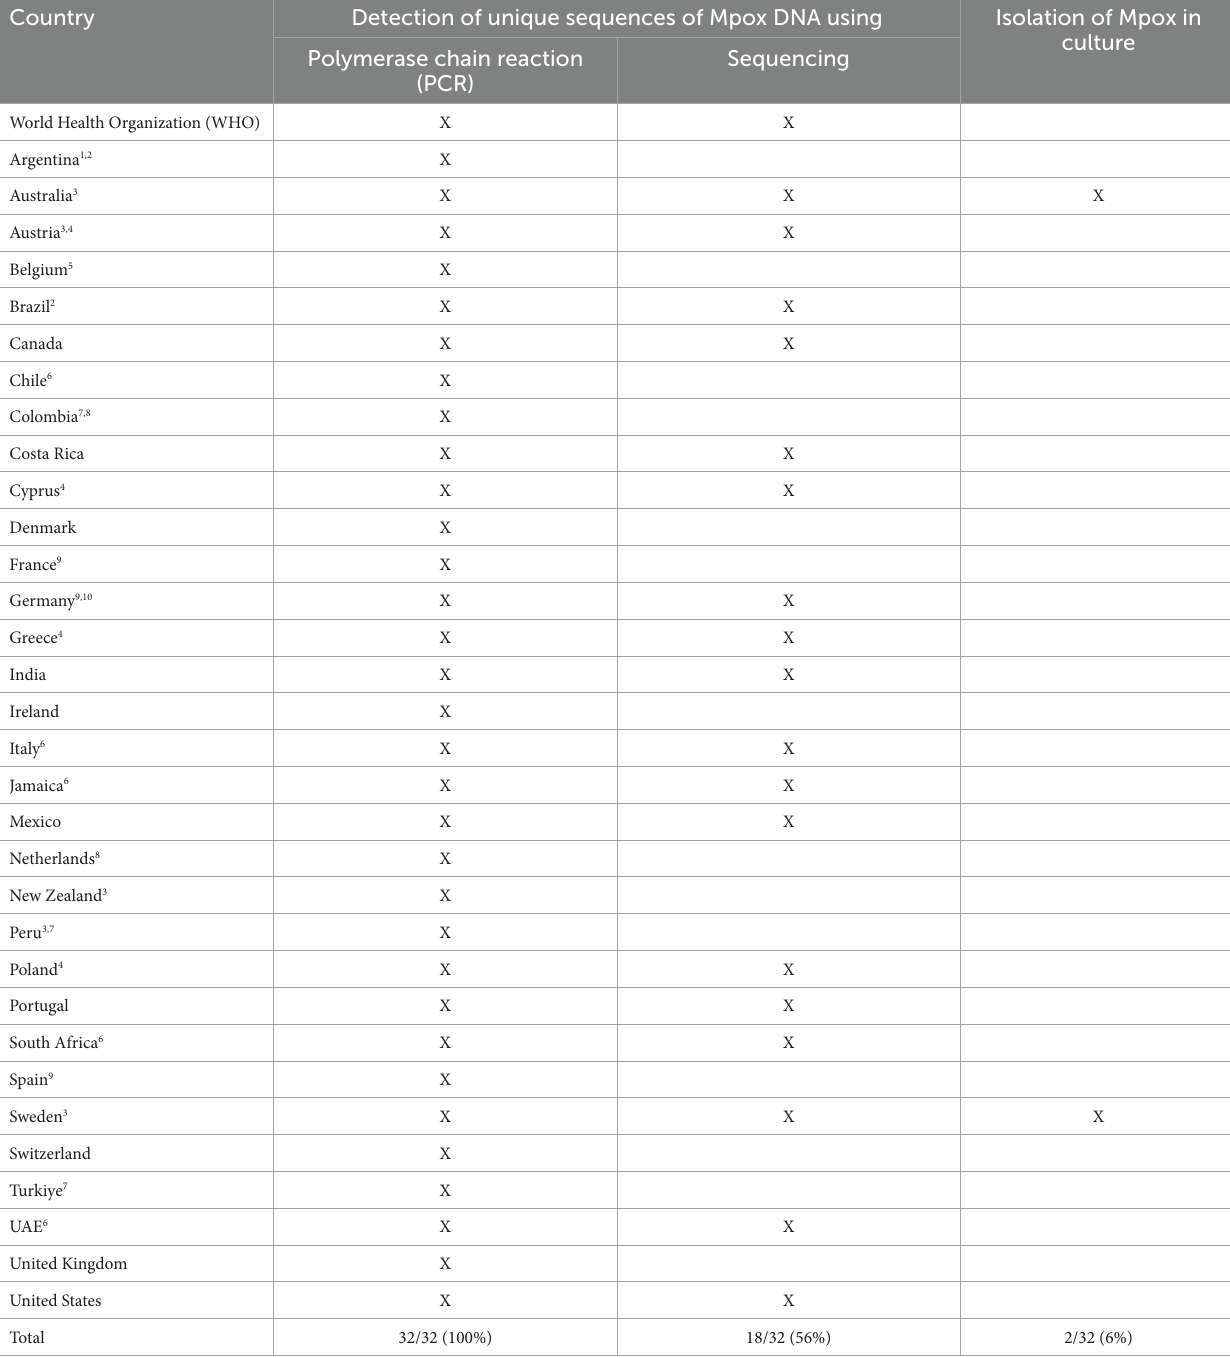
TABLE 1 Criteria for defining Mpox confirmed case in the investigated countries. Country Detection of unique sequences of Mpox DNA